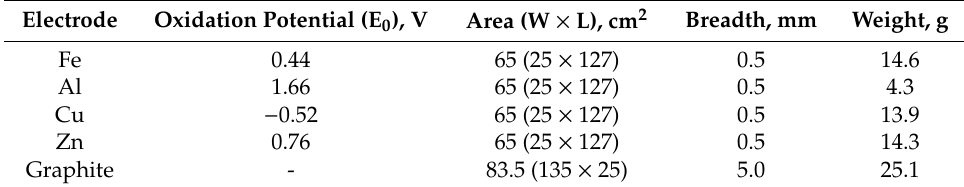
Table 3. Details of di ff erent electrodes used for ECF